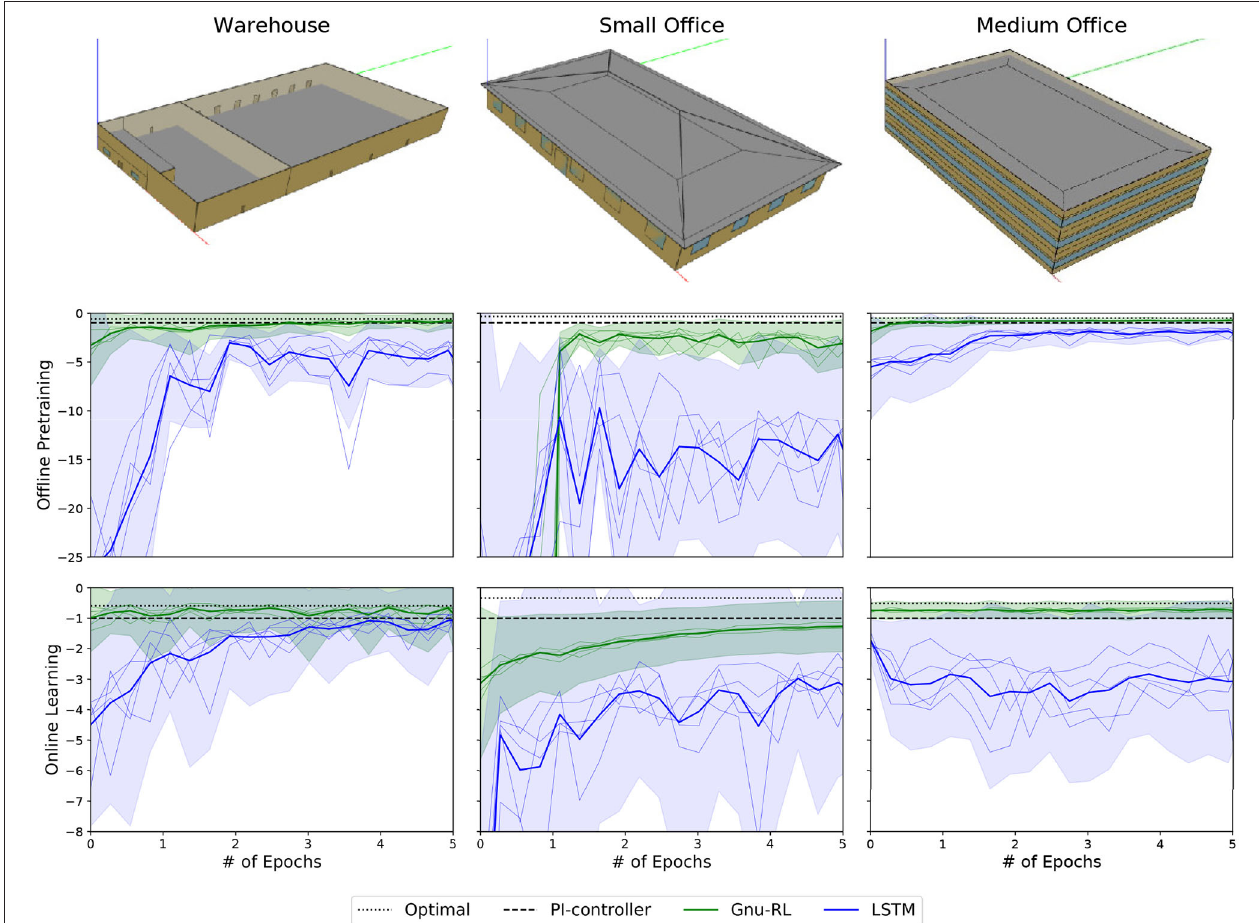
FIGURE 4 | Summary of the experiments on the warehouse , the small office , and the medium office ; Each experiment is repeated over five random seeds. The performance of our proposed Gnu-RL agent is compared to a LSTM policy, during offline pretraining and online learning. We also include two baselines: an optimal LQR and a PI controller. All rewards are normalized by that of the PI controller for the corresponding